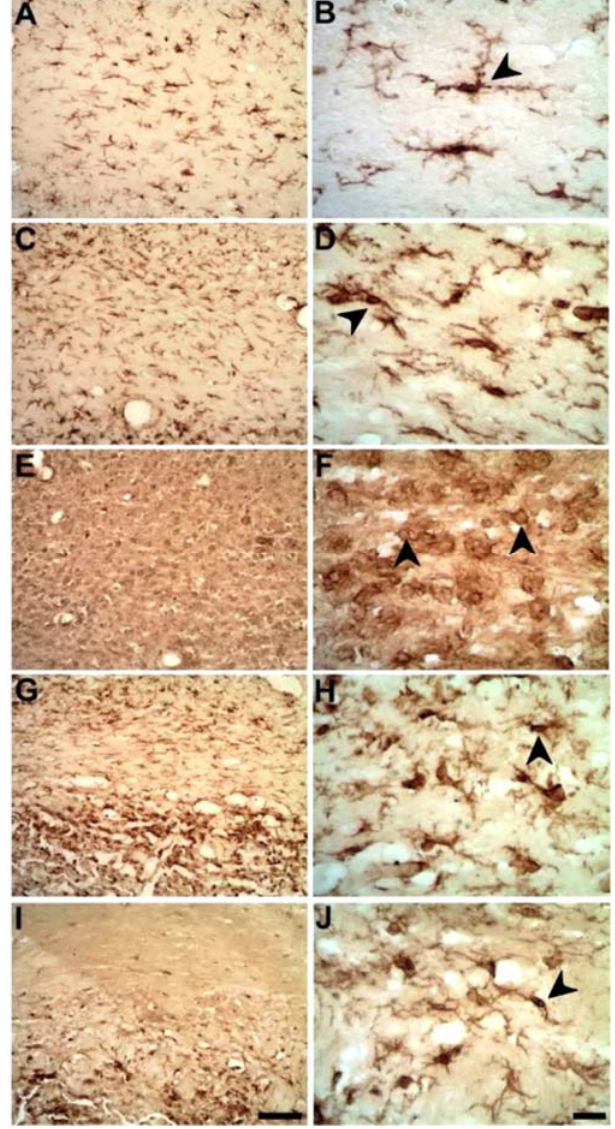
Figure 2. Progressive microglia activation (arrowheads) after striatal ischemia revealed by anti-Iba1 immunolabeling in the corpus callosum. Control animal injected with sterile saline ( A , B ) or ischemic animals injected with ET-1 at 3 ( C , D ); 7 ( E , F ); 14 ( G , H ); and 30 PLD ( I , J ). Left-sided photomicrographs in lower magnification with a scale bar of 20 μ m, and right-sided ones, with higher magnification with a scale bar of 100 μ m.